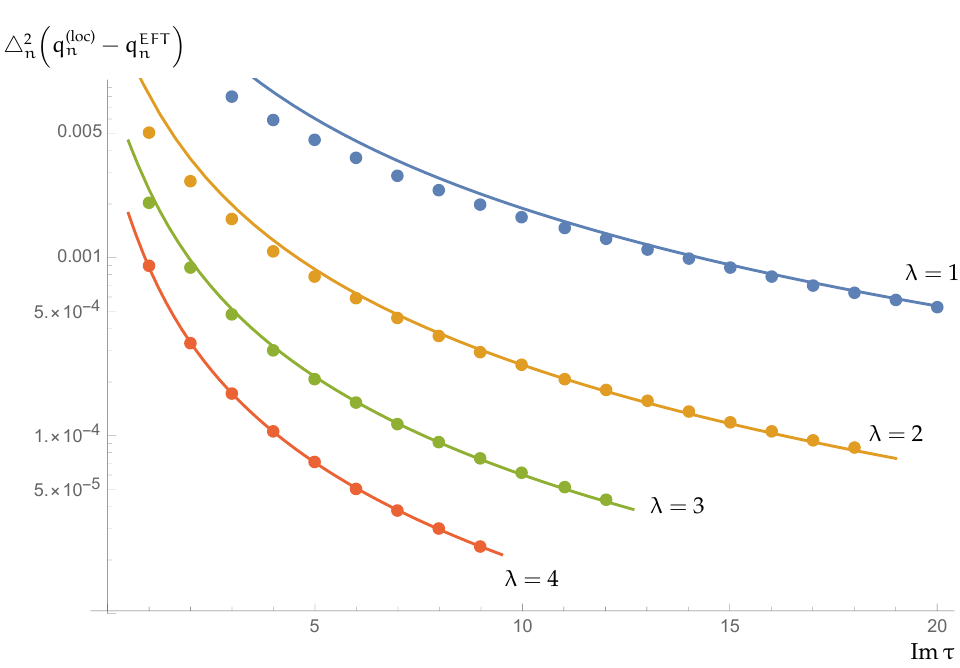
Figure 2 . Second di(cid:11)erence in n for the discrepancy between localization and EFT